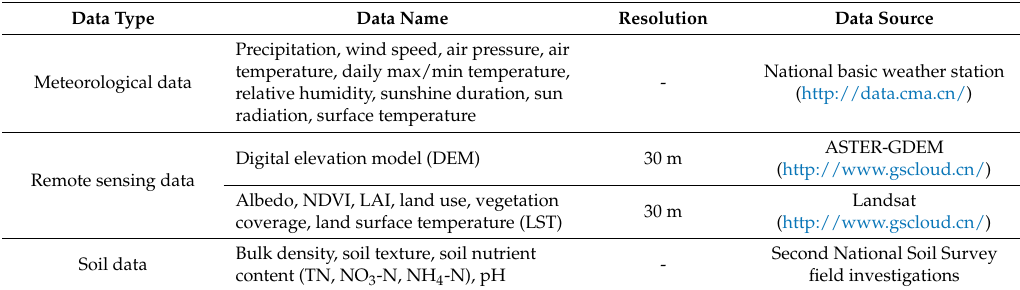
Table 2. Information for the multi-source data.